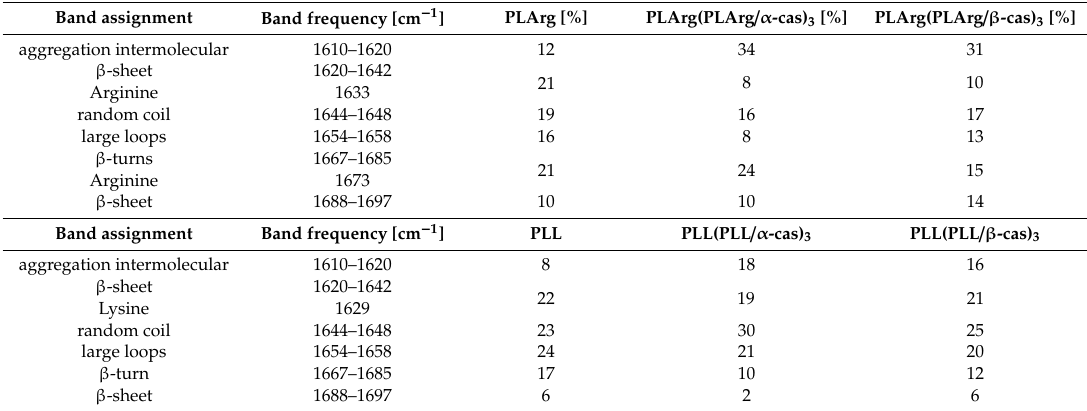
Figure 11. Amid I vibration band for polypeptide film (black) and for polypeptide layer on top of the multilayer film with caseins for poly-L-arginine (red) and poly-L-lysine (blue). The dash, dash-dot and solid lines denote polypeptide on single bilayer, two bilayer, and three bilayer films, respectively. Table 6. Decomposition of the amide I vibration band into structural components for polypeptide films and the PLArg and PLL layers on top of multilayer films with casein